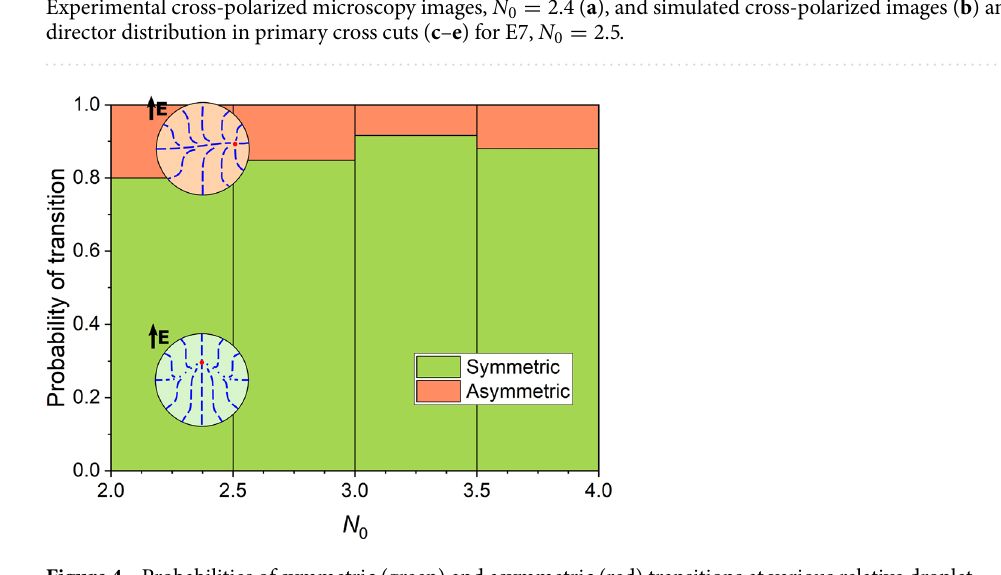
Figure 4. Probabilities of symmetric (green) and asymmetric (red) transitions at various relative droplet helicity parameters N 0 , experimentally measured for 745 E7 droplets in